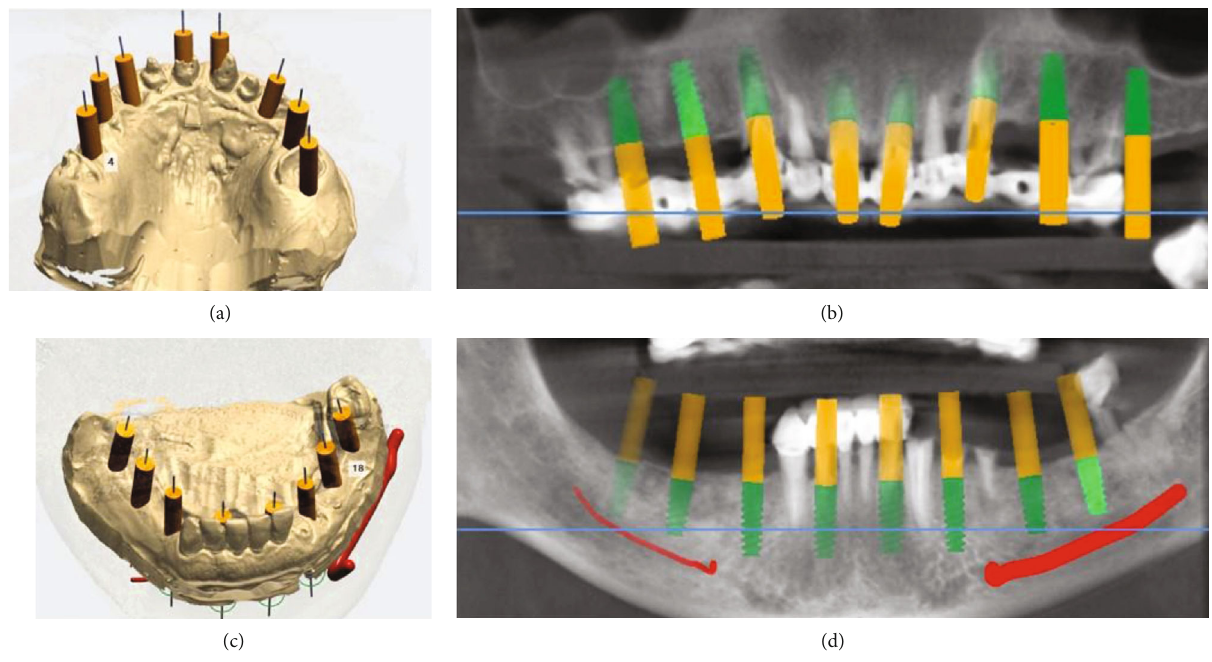
Figure 2: Dental implants positions on maxilla (a, b) and mandible (c, d).